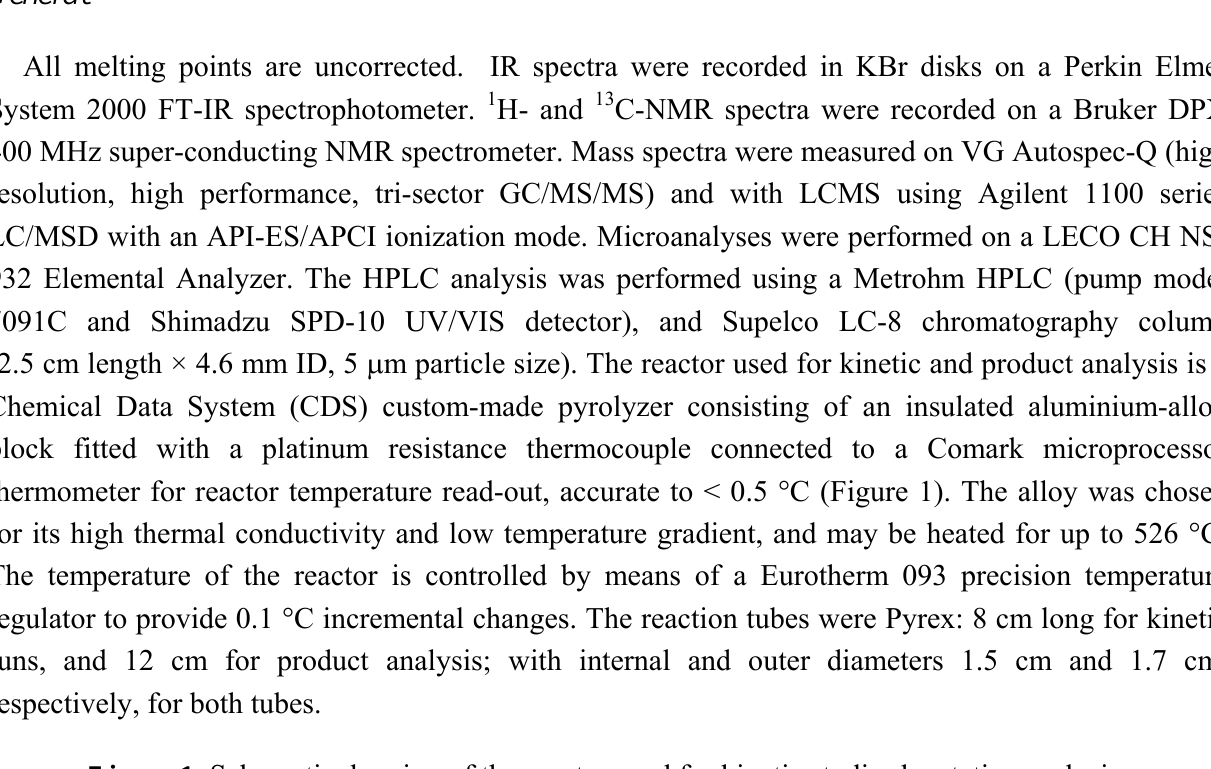
Figure 1. Schematic drawing of the reactor used for kinetic studies by static